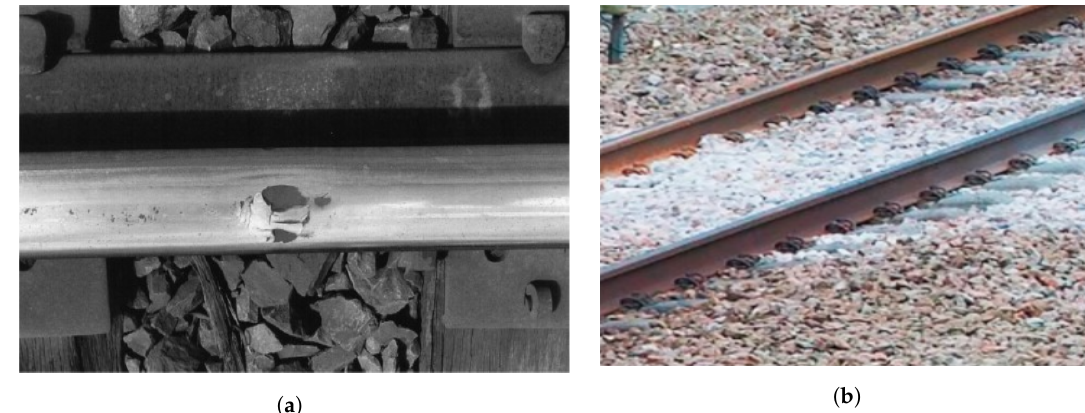
Figure 2. Wheel burn and ballast issue on railway track, ( a ) Wheel burnt issue on railway track [9]; ( b ) Week and expired ballast issue